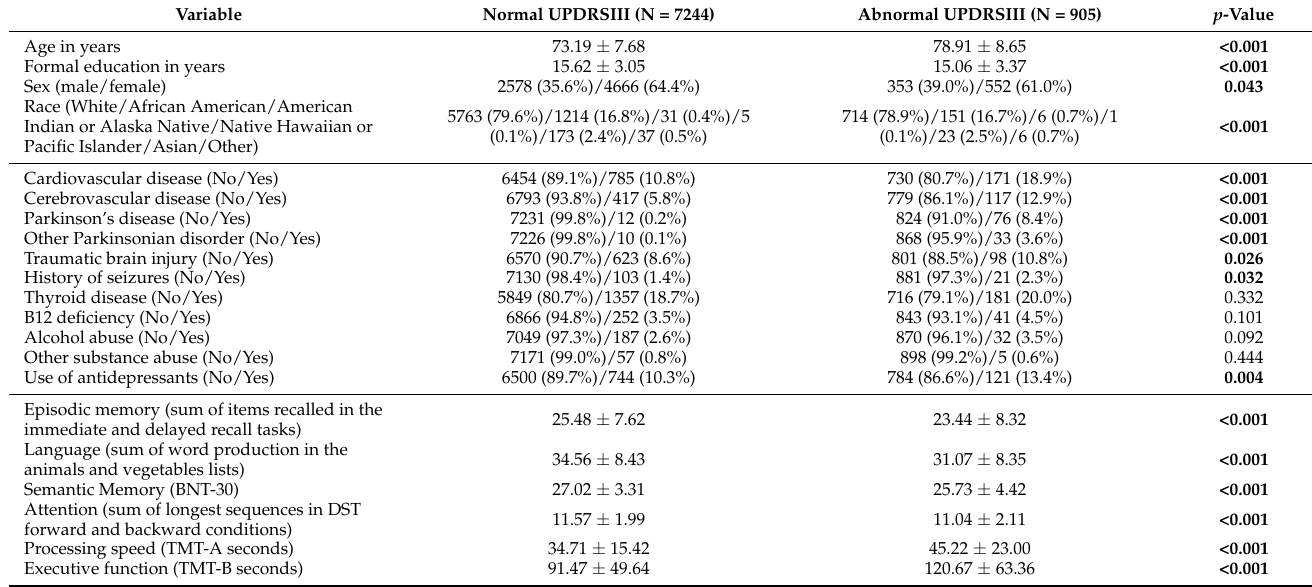
Table 1. Baseline differences between cognitively unimpaired individuals with normal and with abnormal